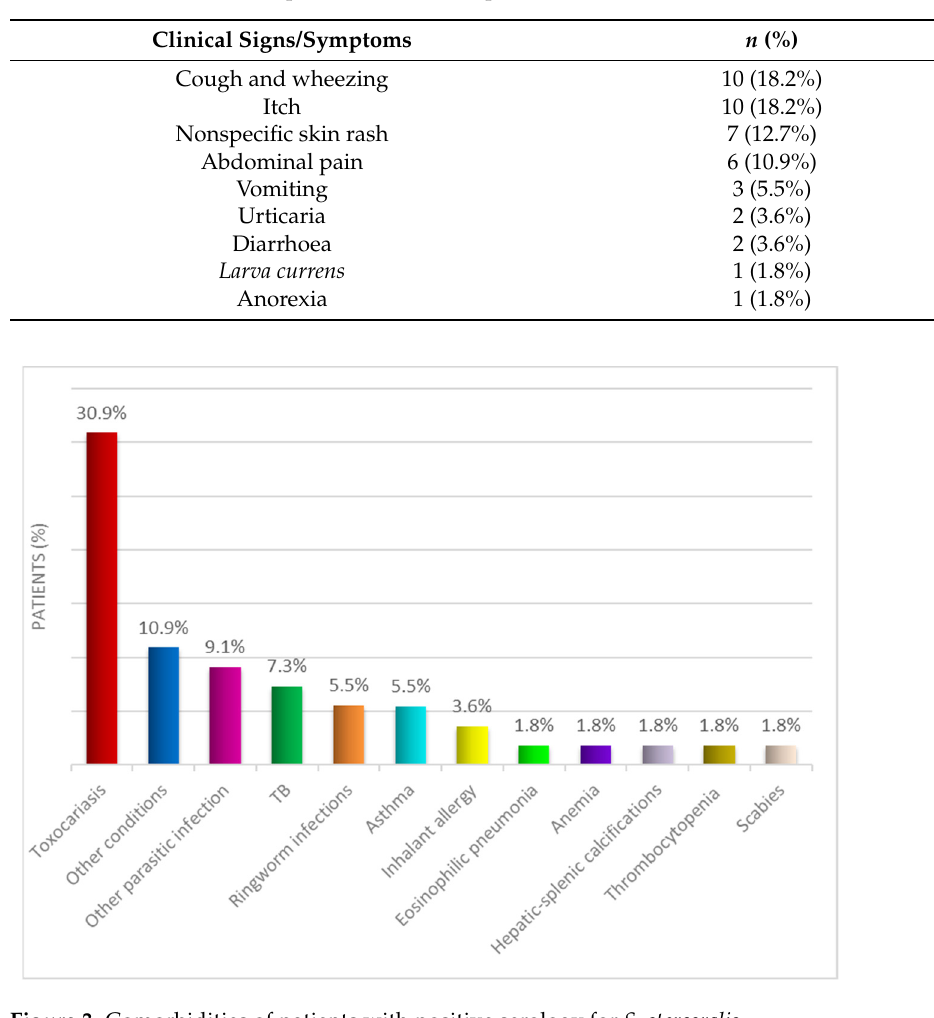
Table 3. Clinical features of patients who tested positive for S. stercoralis